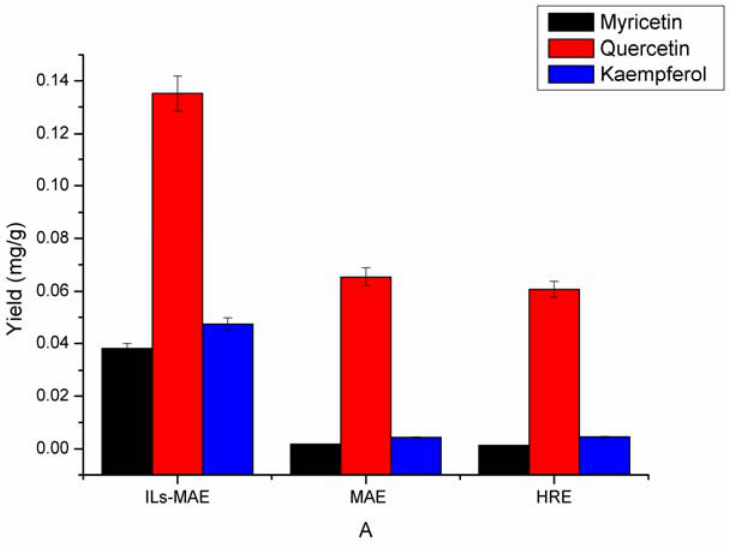
Figure 5. The extraction yields using different extraction methods (extraction time: 10 min;